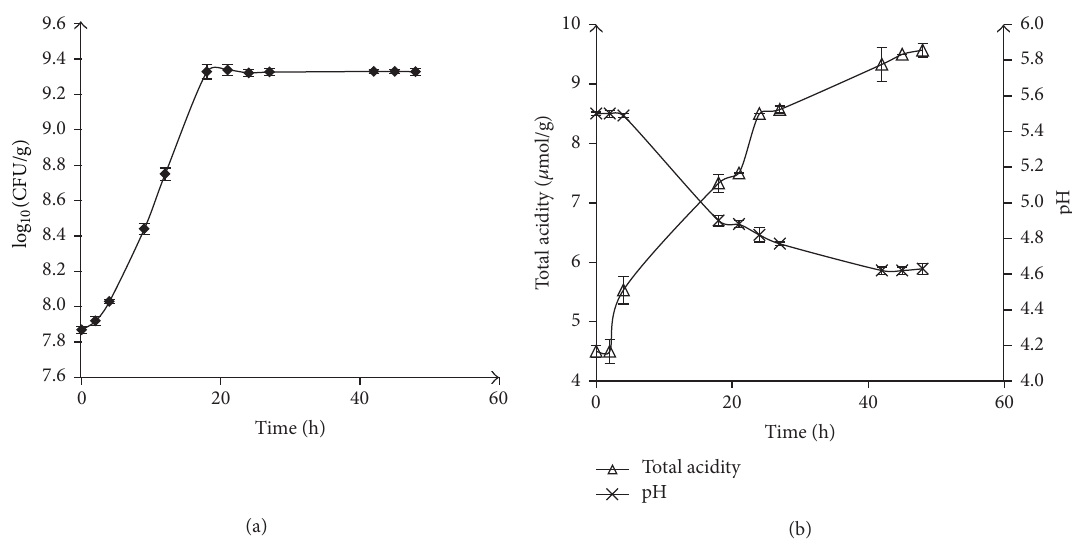
Figure 1: Evolution of Lb. rhamnosus (a) and pH and total acidity (b) during fermentation of